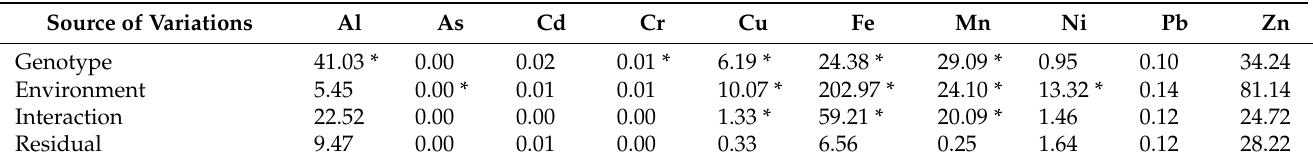
Table 7. Two-way ANOVA of potentially toxic elements (* = p < 0.05).